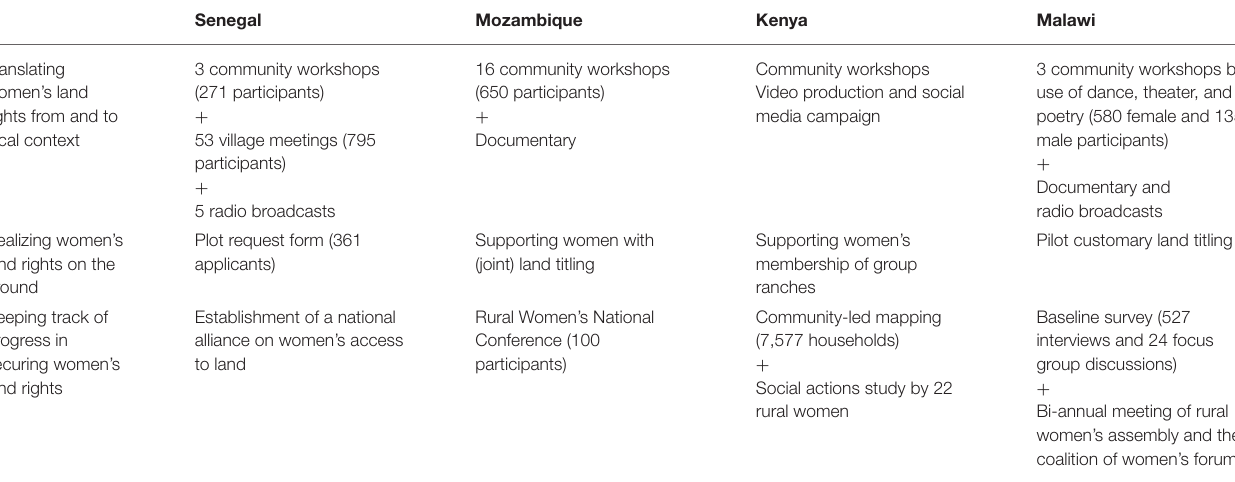
TABLE 1 | Grassroots organizations’ activities within the women’s land rights action-research